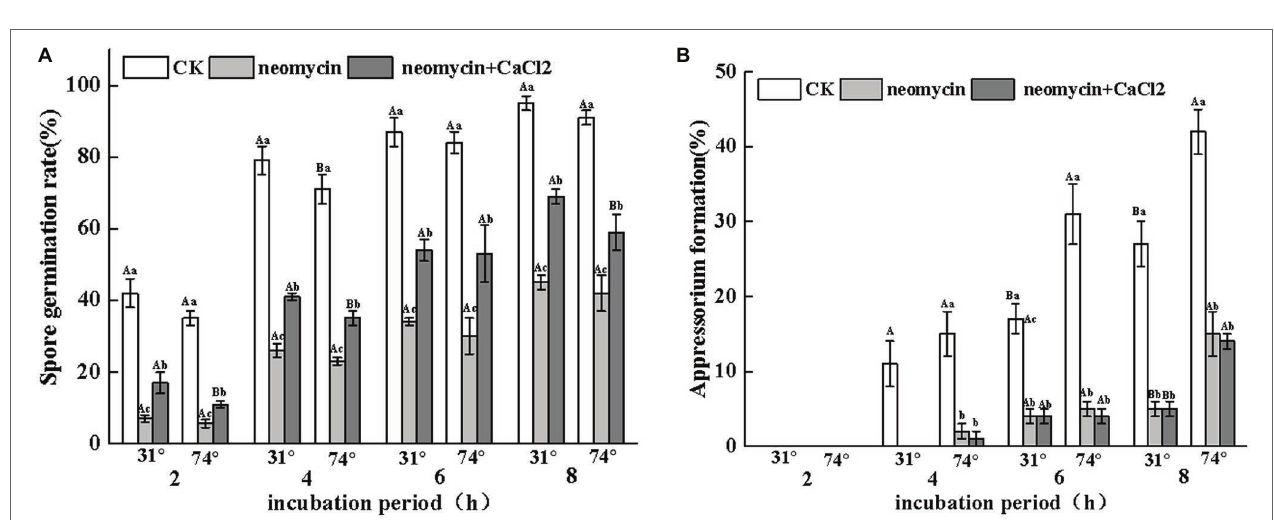
FIGURE 5 | Effects of neomycin on spore germination (A) and appressorium formation (B) in A. alternata induced by hydrophobicity. Conidial suspensions treated with neomycin (10 μ M) and exogenous Ca 2+ (1 mM) were placed onto the hydrophilic and hydrophobic surfaces of Gelbond. Vertical lines indicate standard error (± SE ) of the means. Uppercase letters indicate inter-group differences. Lowercase letters indicate intra-group differences. Different letters indicate significant differences ( p <